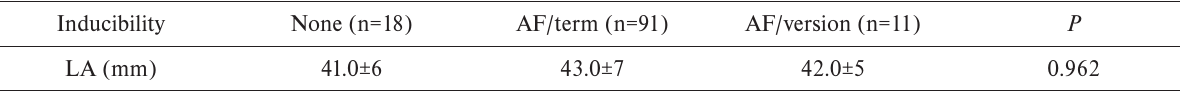
Table 5. The difference in LA diameter in different inducibility groups.